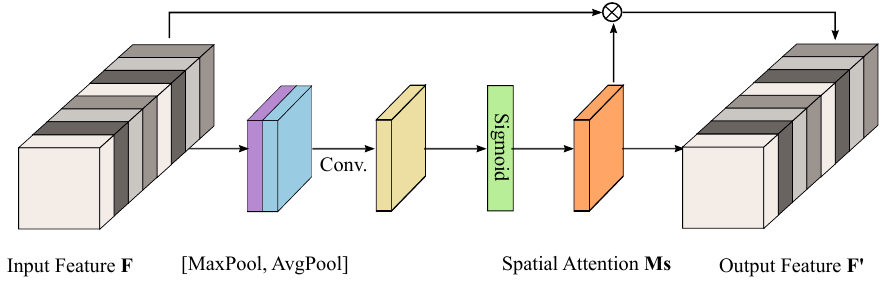
Figure 2. Spatial Attention Module.